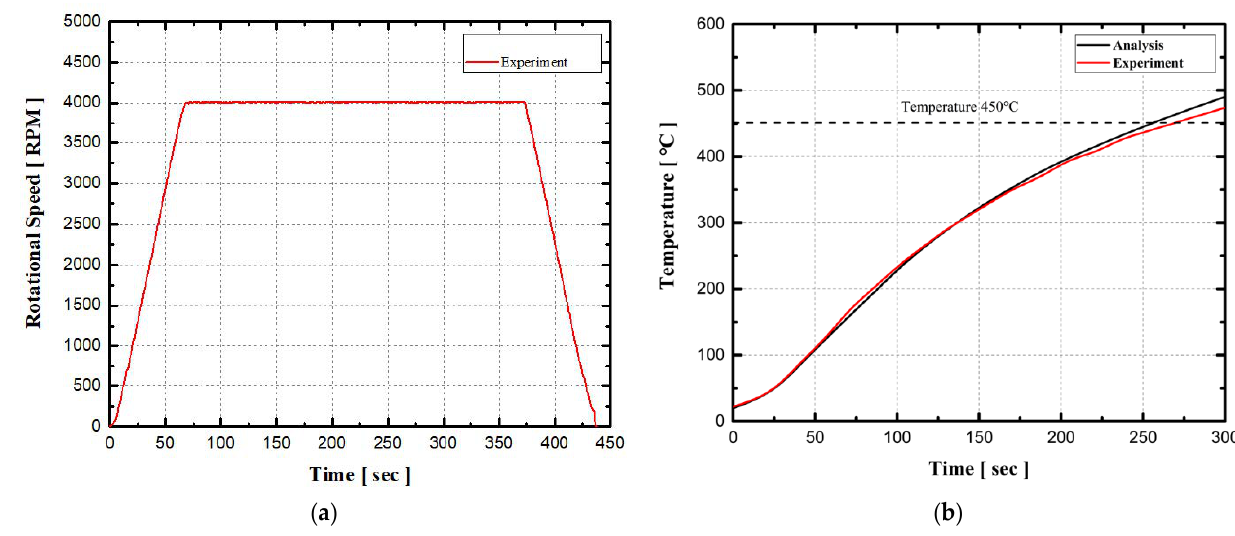
Figure 7. Comparison of analysis and experiment results: ( a ) RPM – time curve; and ( b ) temperature – time graph.